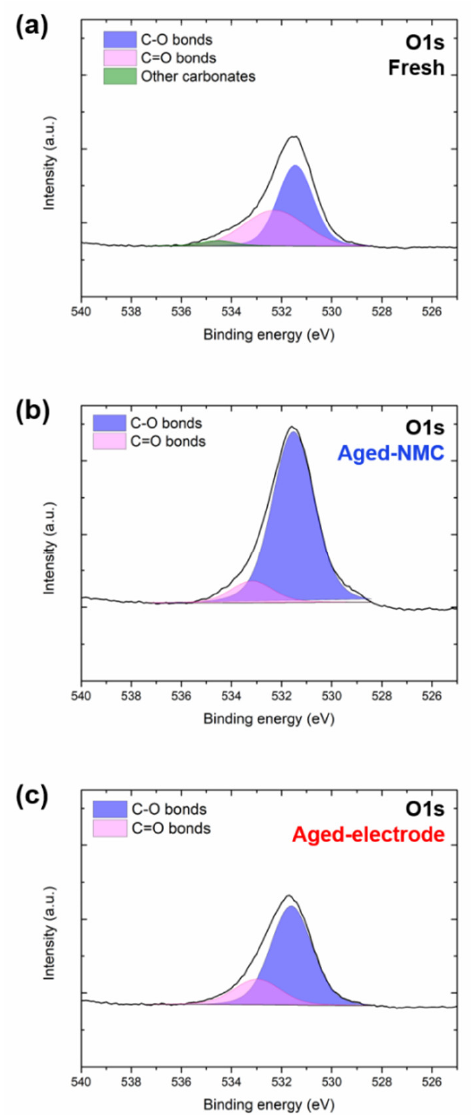
Figure 8. XPS spectra of the NMC811 coatings: O1s region of the ( a ) fresh, ( b ) aged-NMC and ( c ) aged-electrode coatings.